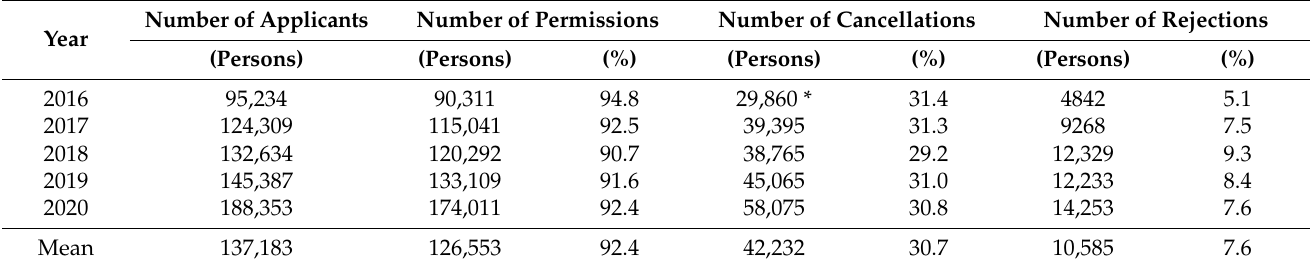
Table 4. The number of applicants, permitted users, and rejected users of the ecological-protected area in Taroko National Park (2016–2020).